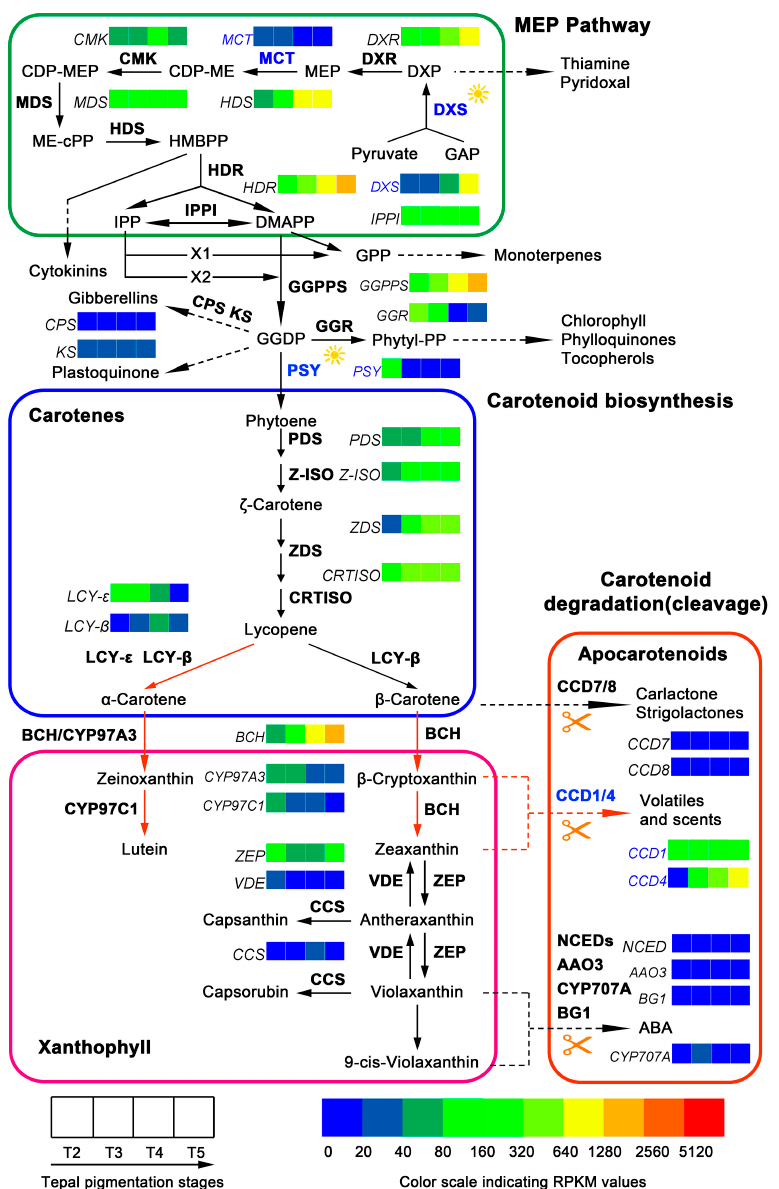
Figure 8. Carotenoids metabolic pathway in tepals of Chinese narcissus and gene expression changes during tepal pigmentation process. The pathway is divided into three sub-pathways based on the functions of unigenes. The additive expression changes of unigenes at different tepal pigmentation stages (T2, T3, T4 and T5) are shown by color grids based on RPKM value. The presumed critical genes DXS , MCT , PSY , and CCD1/CCD4 in the pathway are marked with blue color. Black filled arrows indicate the substance metabolism directions; red filled arrows indicate two dominant flux of carotenoids metabolic pathway in tepals. Enzymes marked with sunlight indicate their catalytic activities can be influenced by light.